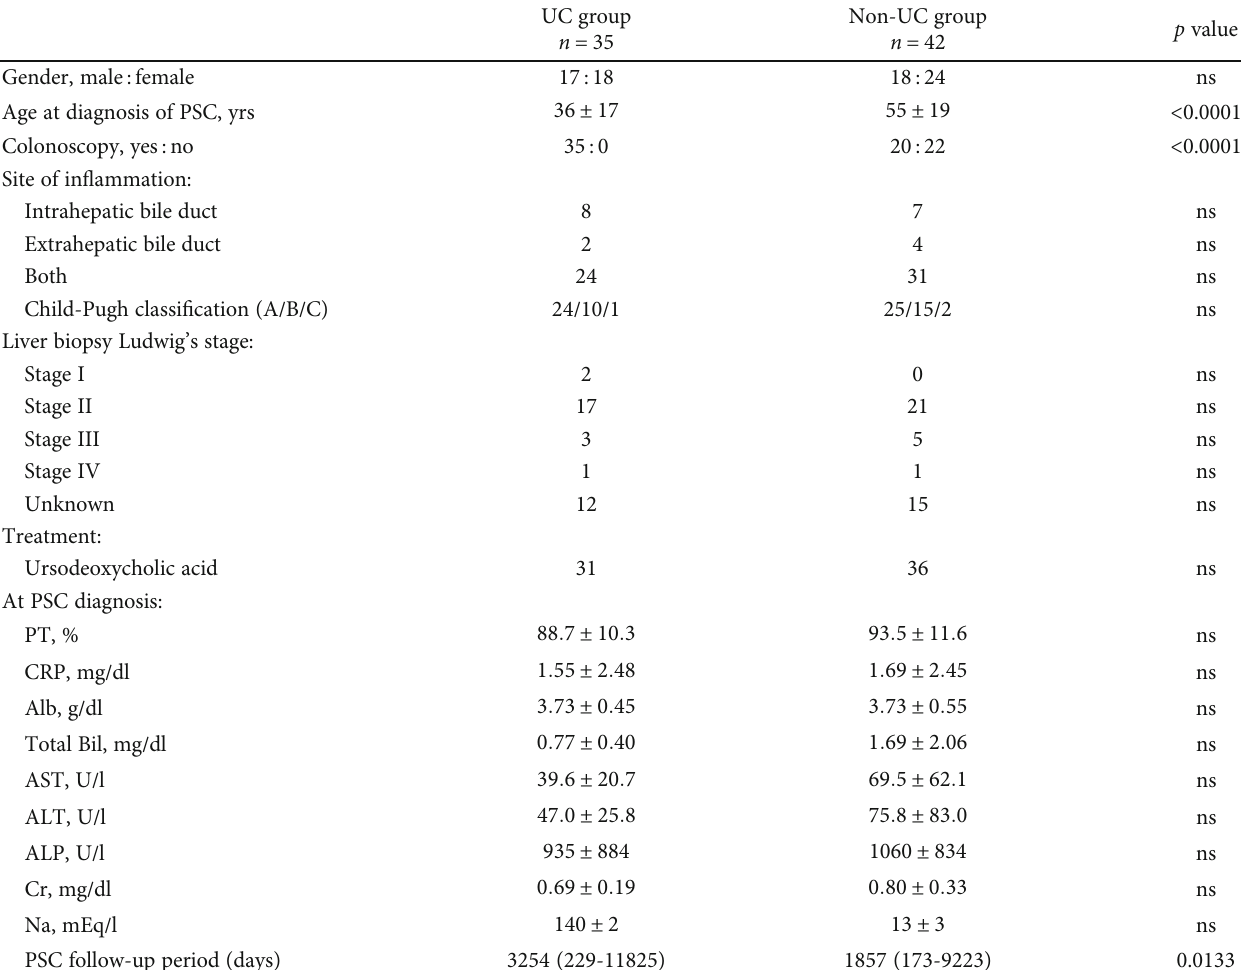
Table 3: Clinical characteristics of the total PSC patient